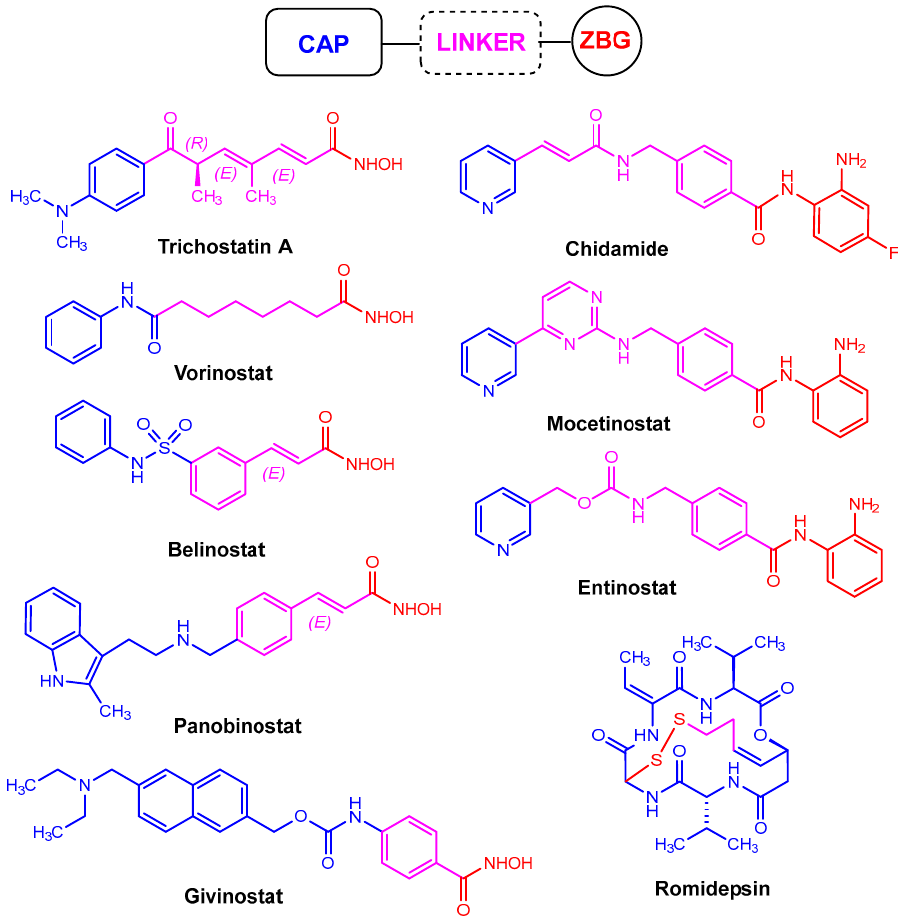
Figure 1. Chemical structures of some HDACis considering the pharmacophore consisting of cap, linker, and zinc-binding group (ZBG).